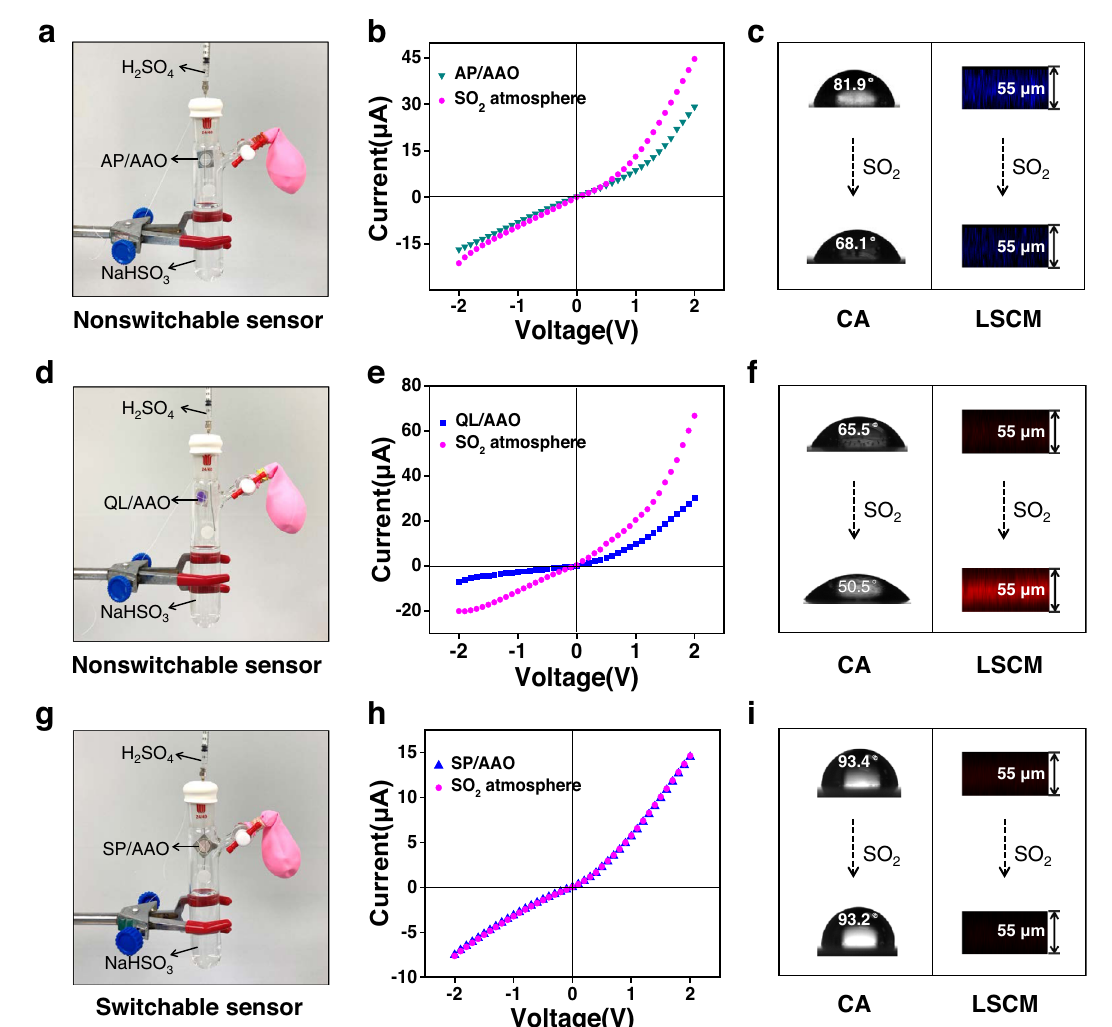
Fig. 5 | Stability and preservation of SP/AAO nanochannels. Construction of microcon fi ned SO 2 atmosphere for ( a ) AP/AAO nanochannels, ( d ) QL/AAO nano- channels, and ( g ) SP/AAO nanochannels. I – V curves of ( b ) AP/AAO nanochannels, ( e )QL/AAOnanochannels,and( h )SP/AAOnanochannelsbeforeandafter4daysof exposure to the SO 2 atmosphere. c, f, and i Corresponding CA change on the